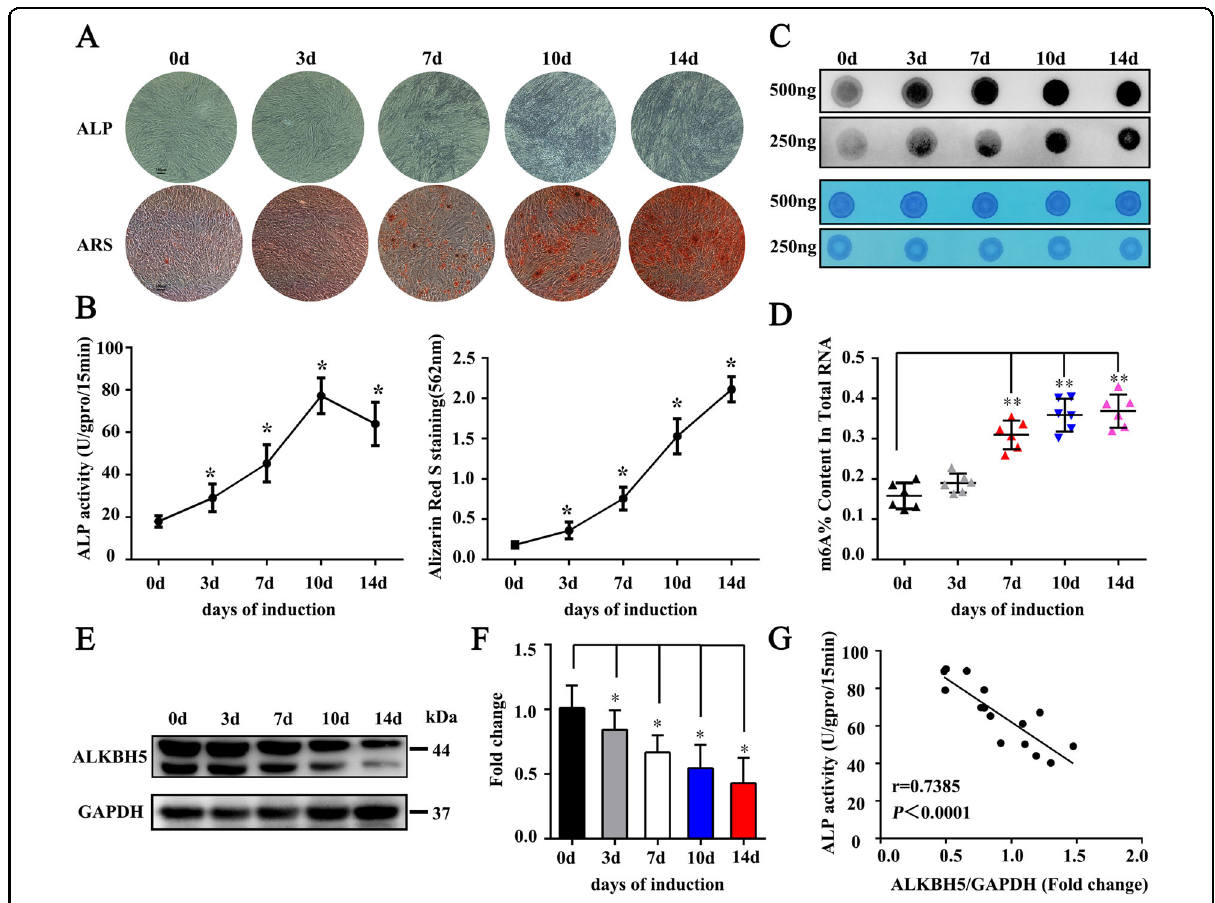
Fig. 2 The overall m 6 A modi fi cation level increased during the osteogenic differentiation of MSCs. MSCs were cultured in osteogenic medium for up to 14 days. A ARS staining (top) and ALP staining (bottom) during the osteogenic differentiation of MSCs. Scale bar, 100 µm. B ALP activity was determined as units per gram of protein per 15 min and ARS staining was quanti fi ed as the absorbance at 562 nm ( n = 3 independent experiments with three different MSC lines). C m 6 A dot blot detection of the overall m 6 A modi fi cation level at different osteogenic differentiation time points ( n = 6). D An m 6 A RNA methylation assay was used to detect the overall m 6 A modi fi cation level at different time points ( n = 6). E , F Protein level of ALKBH5 during osteogenic differentiation of MSCs ( n = 9). G Correlation analysis of the expression level of ALKBH5 and ALP activity ( n = 15). All data are presented as the means ± SDs. * p <